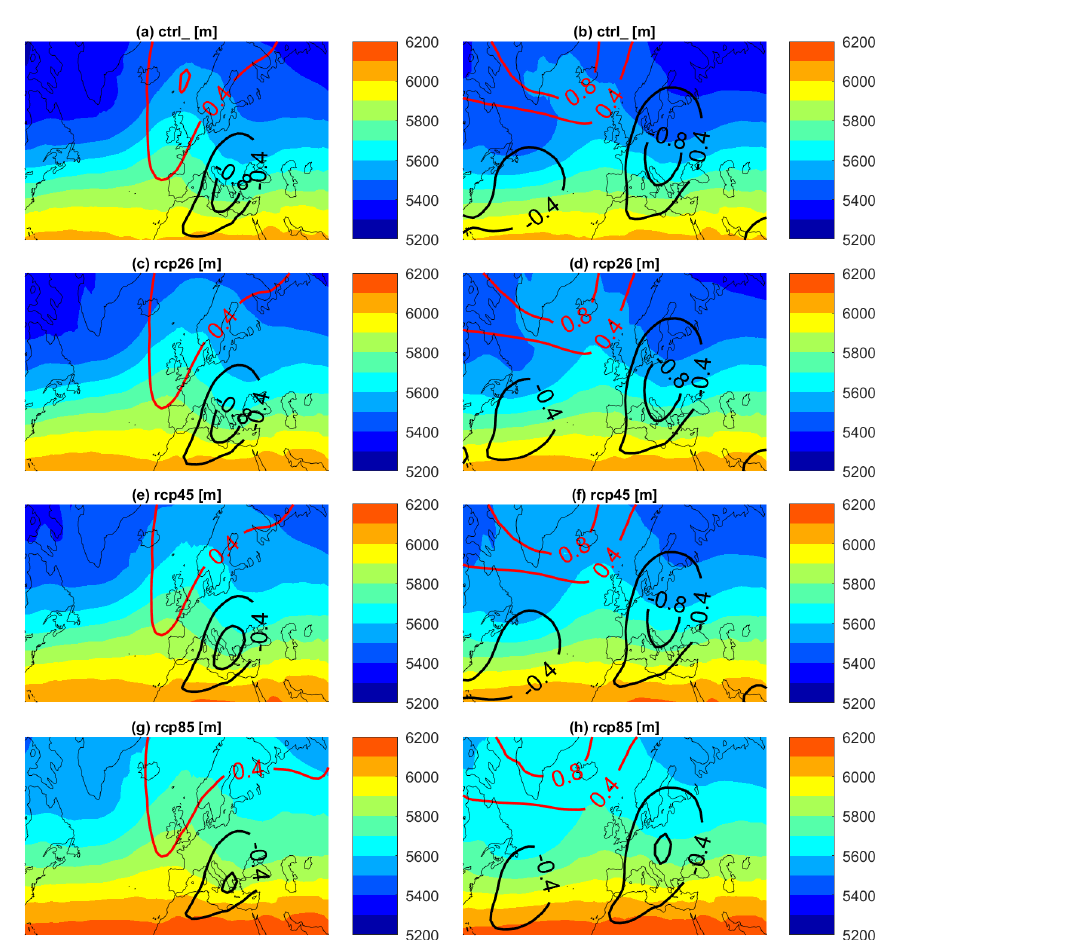
Figure 6. The figure shows the 500hPa geopotential heights in PlaSim simulations: average of the 500hPa geopotential height [m] for cluster 1 (a, c, e, g) and cluster 2 (b, d, f, h) of analogues. (a, b) Control run. (c, d) RCP2.6 run. (e, f) RCP4.5 run. (g, h) RCP8.5 run. Isolines represent positive (in red) and negative (in black) standardized